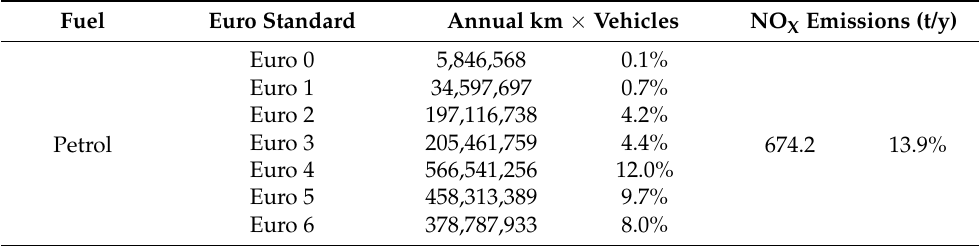
Table 2. Province of Milan (2018): Circulating car fleet composition by fuel and the Euro standard (total annual driven kilometers), and the contributions by Euro standard to NO X car emissions